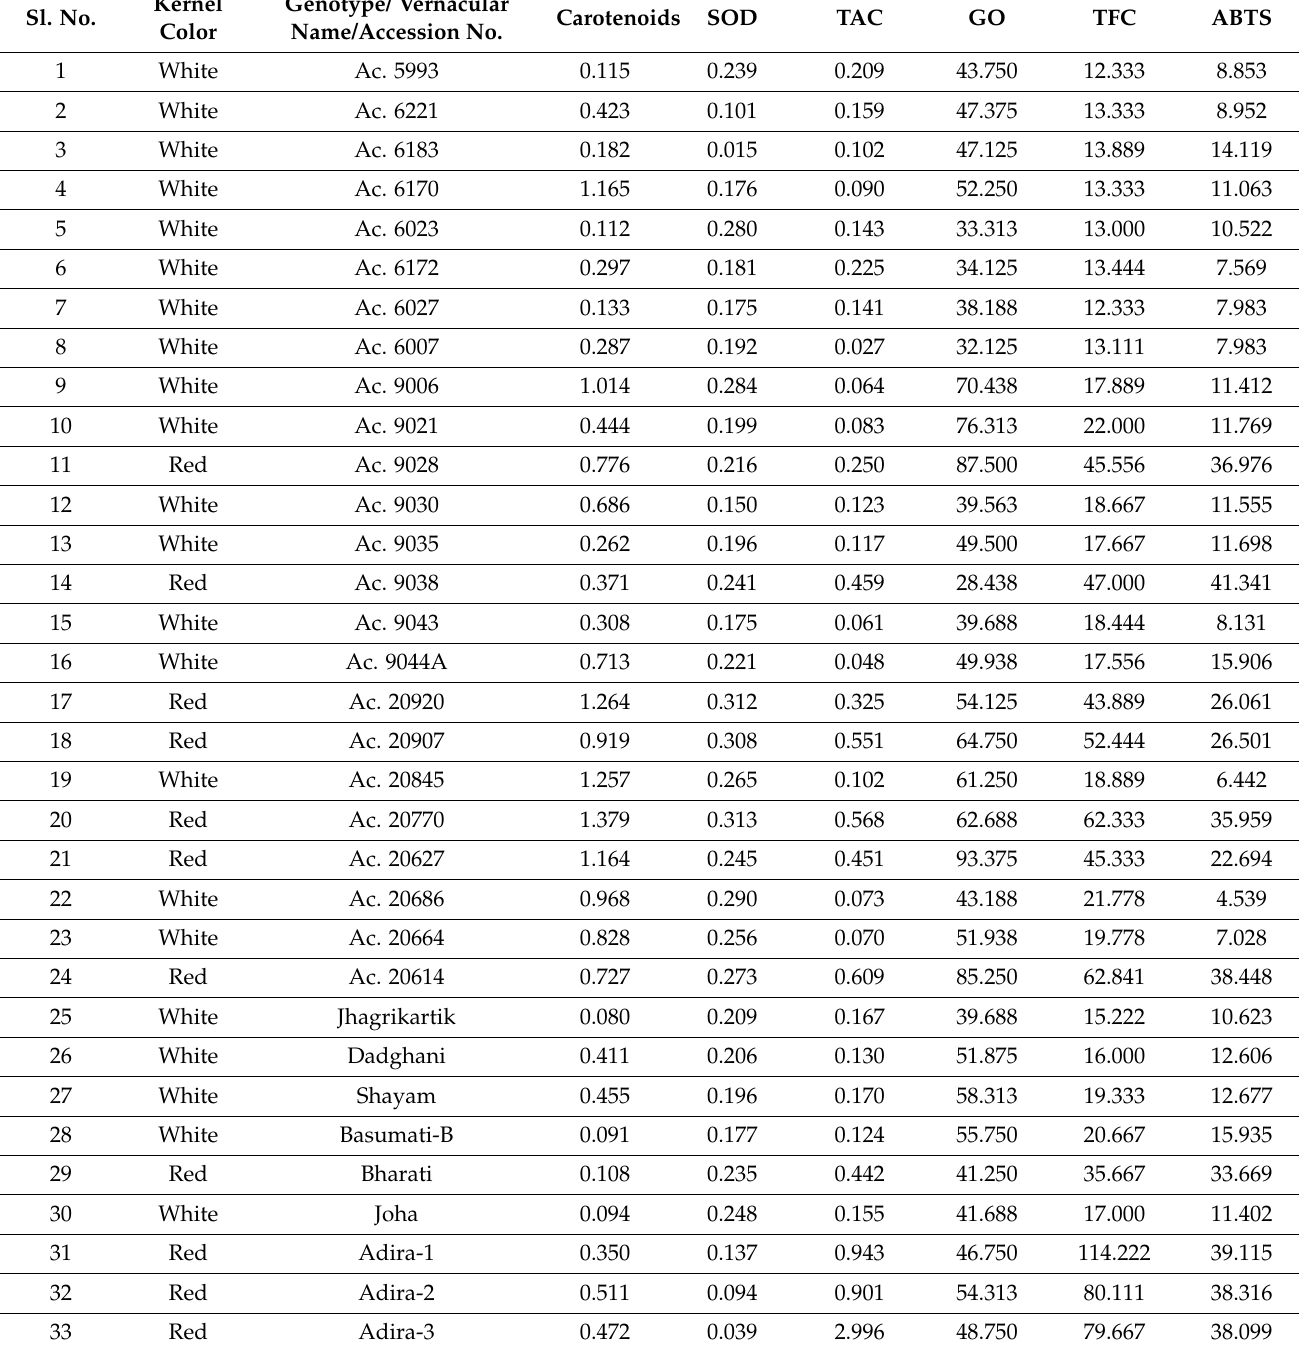
Table 1. Mean values of carotenoids, SOD, TAC, GO, TFC, and ABTS antioxidants estimated from 120 genotypes present in the panel